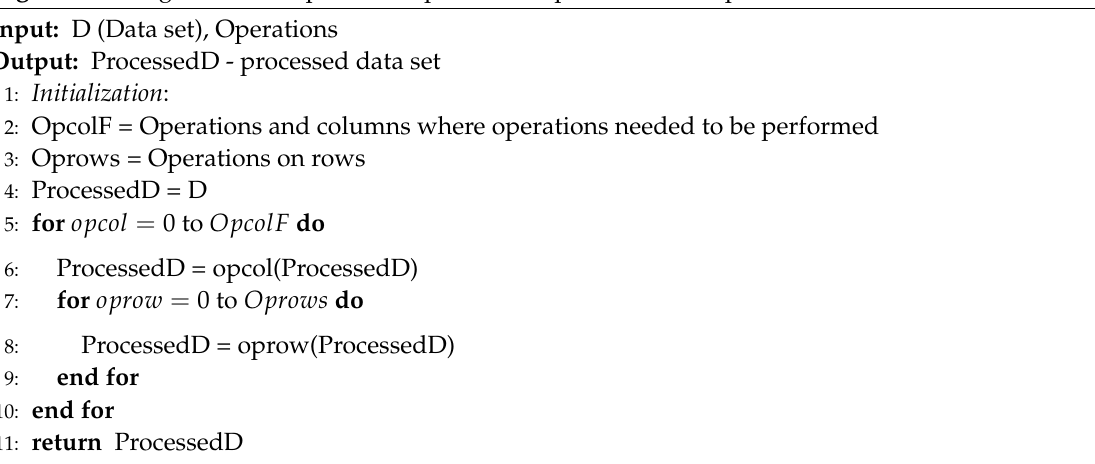
Algorithm 2 Algorithm for operational precedence process of BAT